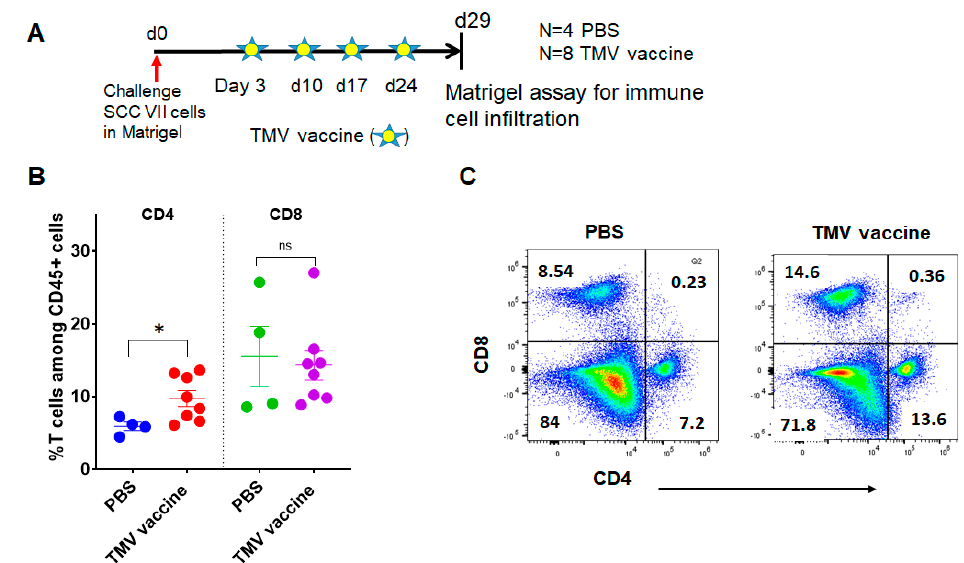
Figure 3. TMV vaccine increases T cell infiltration into SCC VII tumors. SCC VII tumor cells were mixed with Matrigel and the mixture was injected s.c. into the flank of C3H / HeJ mice. TMV vaccine administered every week starting on day 3 after tumor cell inoculation, and the Matrigel was extracted five days after the last dose of TMV vaccine as shown in ( A ). Matrigel plugs were minced with scissors, mashed with plungers, passed through a cell strainer, and extracted cells were processed for flow cytometry to analyze for immune cells using fluorochrome-conjugated antibodies. ( B ) Percentage of CD4 + and CD8 + T cells among CD45 + gated cells, and ( C ) representative flow cytometry analysis plot of tumor infiltrating cells in PBS control and TMV vaccine groups. * p < 0.03; ns: not significant